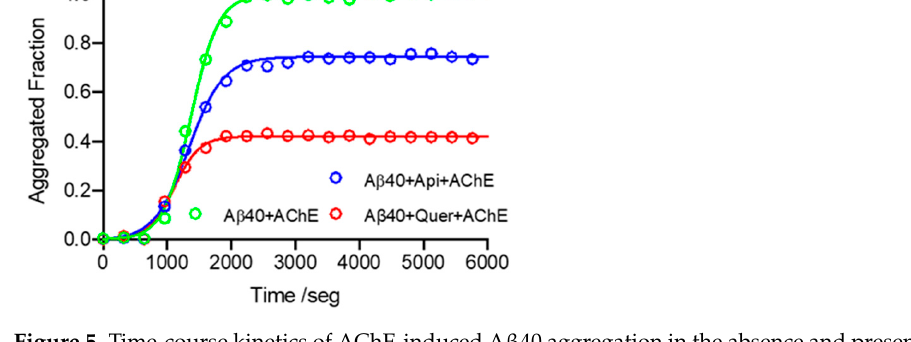
Figure 5. Time-course kinetics of AChE-induced A β 40 aggregation in the absence and presence of the two flavonoids quercetin and apigenin, followed by ThT fluorescence. Green: without flavonoid; blue: with apigenin; red: with quercetin. Conditions: [Quercetin/Apigenin] = 20 μ M; [A β 40] = 20 μ M